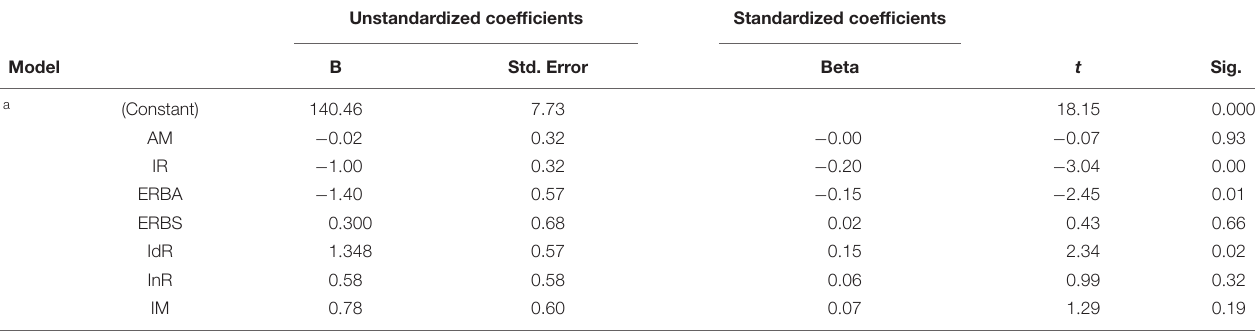
TABLE 7 | Coefficients for the components of motivation and